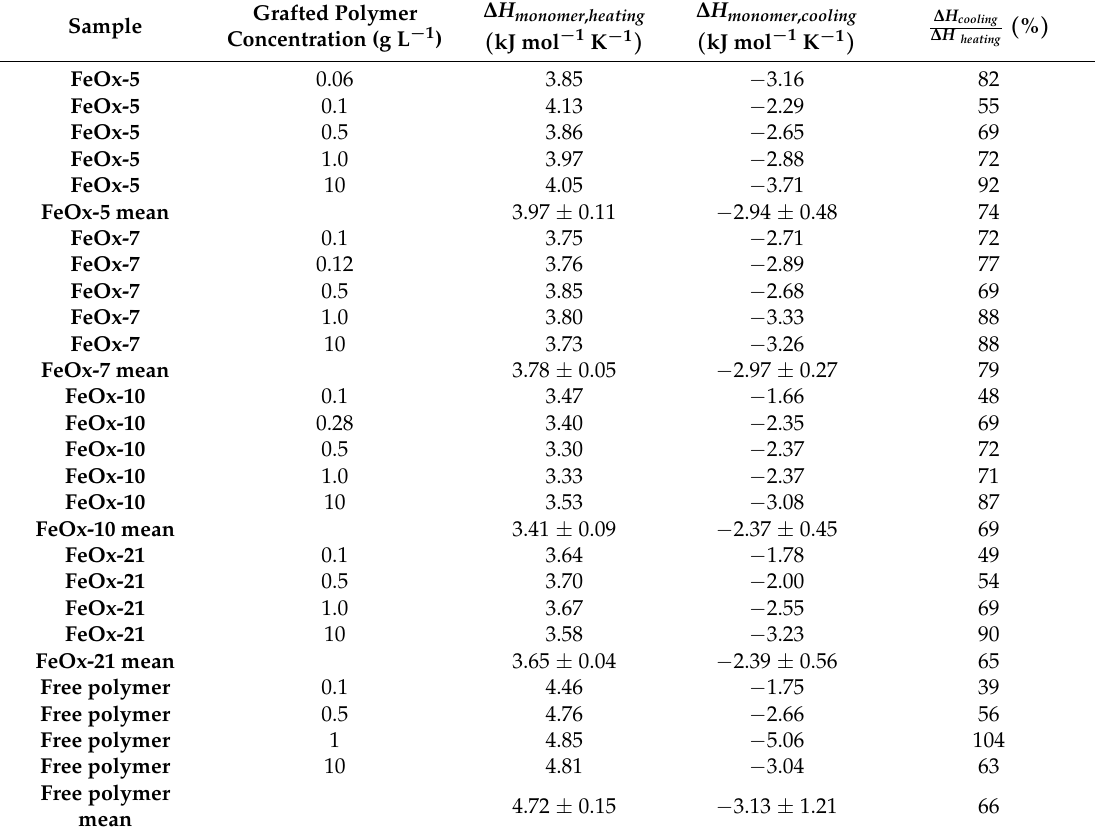
Table 4. Enthalpy per monomer of the polymer solvation transition measured by